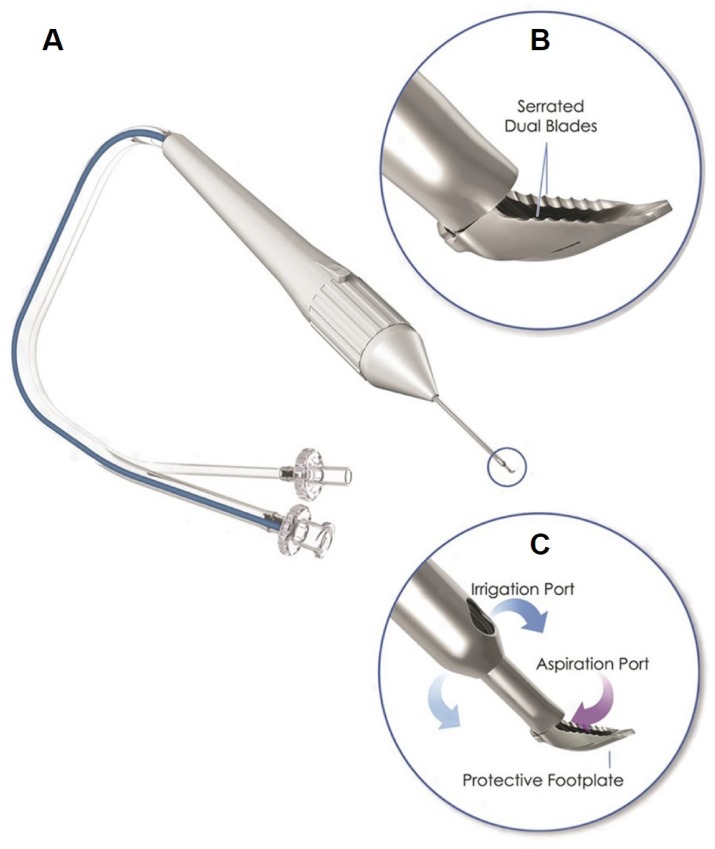
Goniotome surgical system.The Goniotome has two irrigation ports that maintain the chamber (C, blue arrows). The TM is put under stretch by a ramp and excised. TM, blood, and debris are aspirated into the tip (C, red arrow).